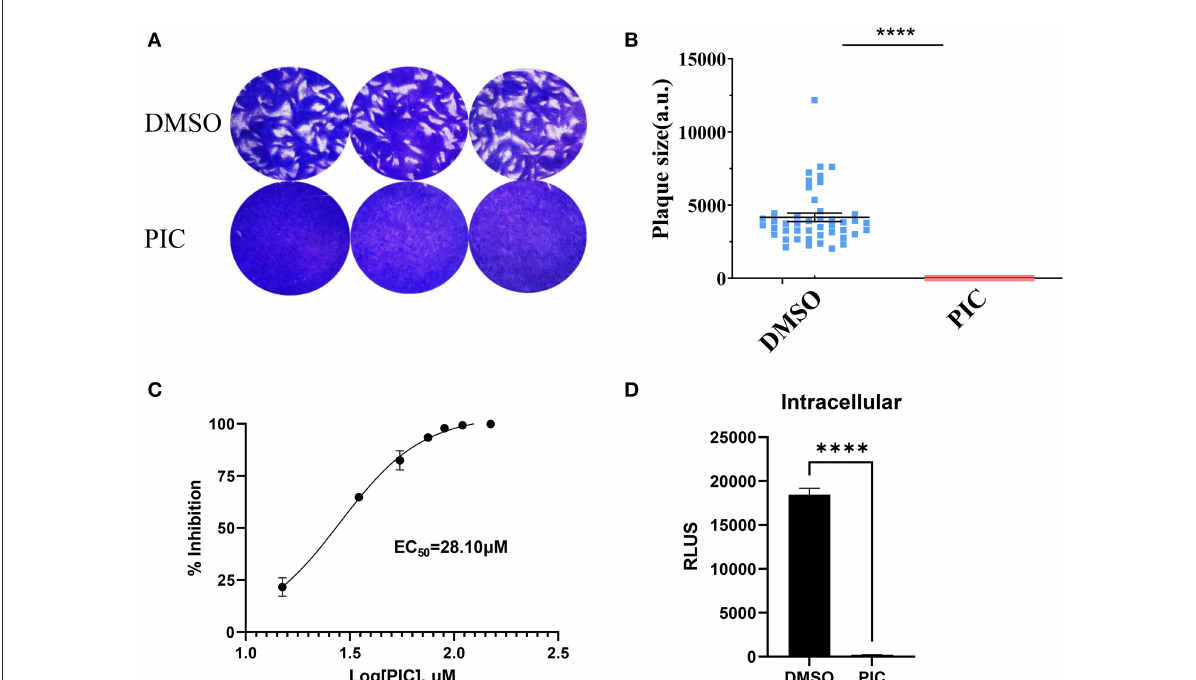
FIGURE1 Piceatannol displaying a dose-dependent inhibitory effect against TgRH-Luc tachyzoites. (A) The Plaque assay for comparing the overall proliferation ability of the parasites after piceatannol and DMSO treatment. TgRH-Luc tachyzoites were added to HFF cells cultured in 12-well plates, with 150 tachyzoites added to each well. Infected cells were treated with DMSO and 100 µ M Piceatannol, respectively. Cells were cultured for 7 days followed by fixation with PFA and staining with 0.2% crystal violet. (B) Measurement of plaque areas using the pixel point using Pixel in the Photoshop C6S software (Adobe, USA). Data were obtained from three independent experiments. Statistical analysis of the plaque area was performed by Graph Pad Prism using Student’s t test. Asterisks indicate p < 0.0001. (C) Inhibition curve of piceatannol on T. gondii in vitro . TgRH-Luc was treated with different concentrations of piceatannol ranging from 0 to 150 µ M, and relative RLU was detected after 24h. Percentage proliferation inhibition was calculated as: inhibition rate = [(RLU DMSO - RLU treatment )/RLU DMSO ] × 100. EC 50 was calculated using the log (inhibitor) vs. response-variable slope (four parameters) regression equation. The results are shown as the mean ± SEM from three independent experiments. (D) Piceatannol inhibition of intracellular T. gondii . Freshly released tachyzoites (1 × 10 5 ) were allowed to invade the host cells for 3h at 37 ◦ C and 5% CO 2 , and then DMEM medium containing piceatannol or DMSO was added after wash three times. The infected cells were cultured for 24h until fluorescence was detected. Data were obtained from three independent experiments. Statistical analysis of the plaque area was performed by Graph Pad Prism using Student’s t test. Asterisks indicate p <